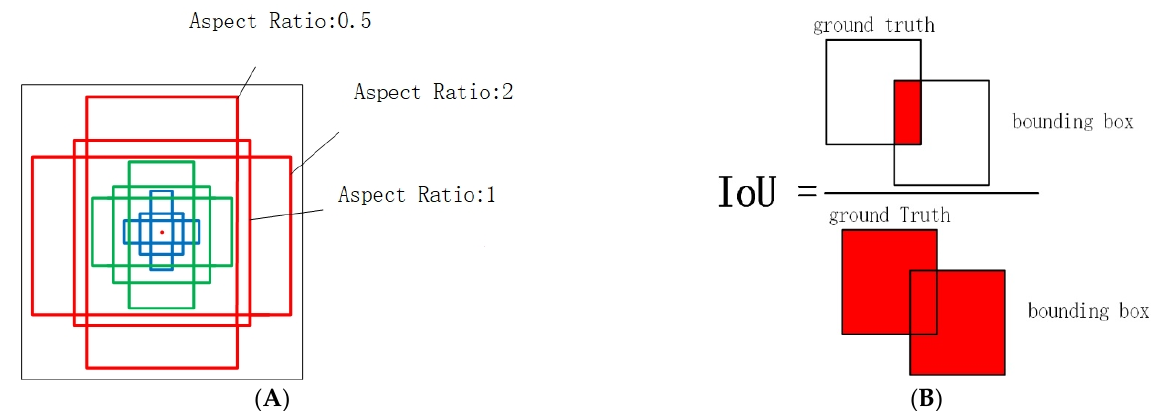
Figure 6. ( A ) Anchor schematic and ( B ) IoU calculation principle.